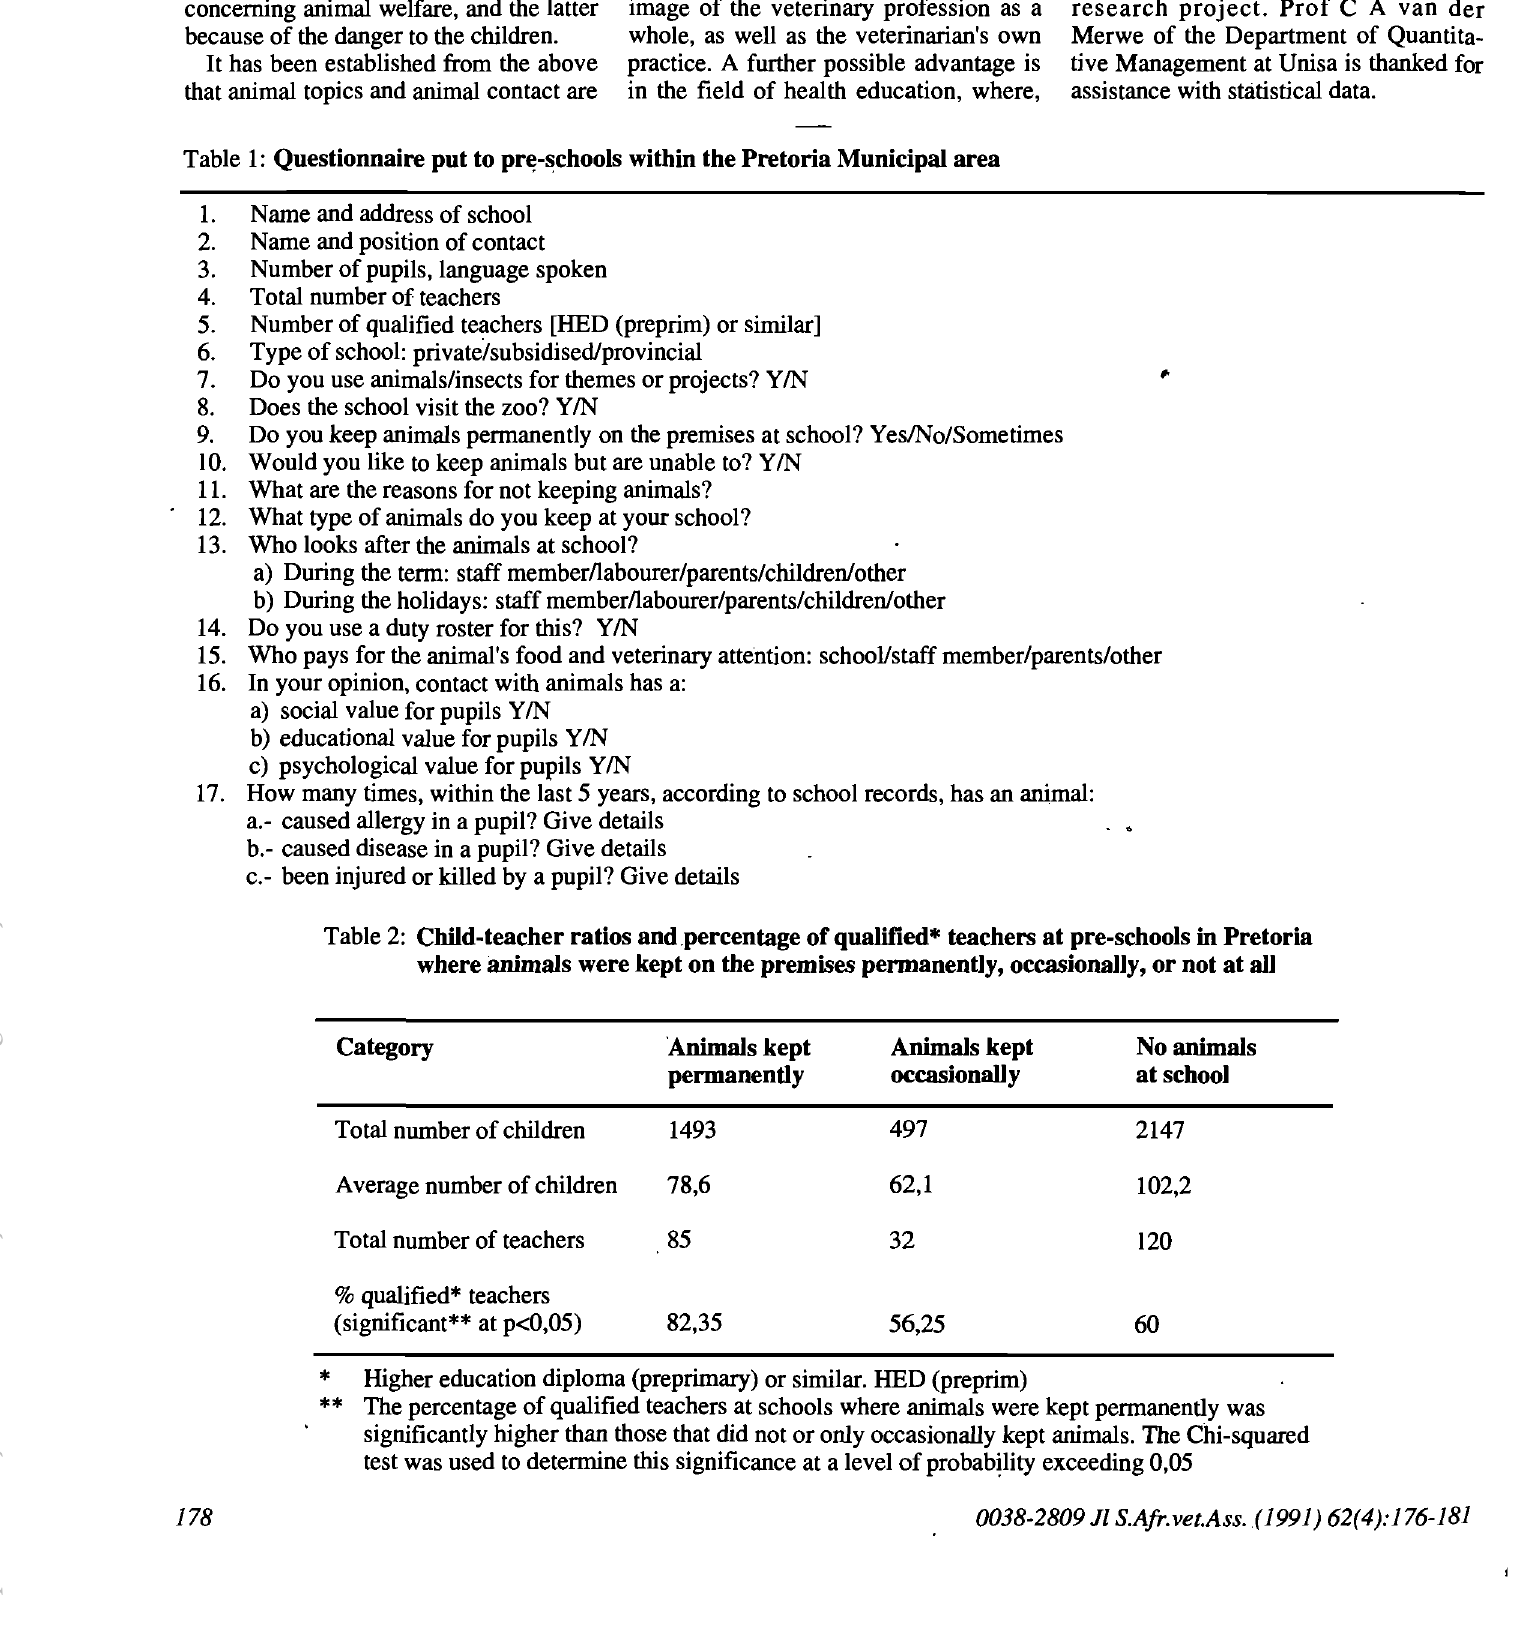
Table 2: Child-teacher ratios and percentage of qualified* teachers at pre-schools in